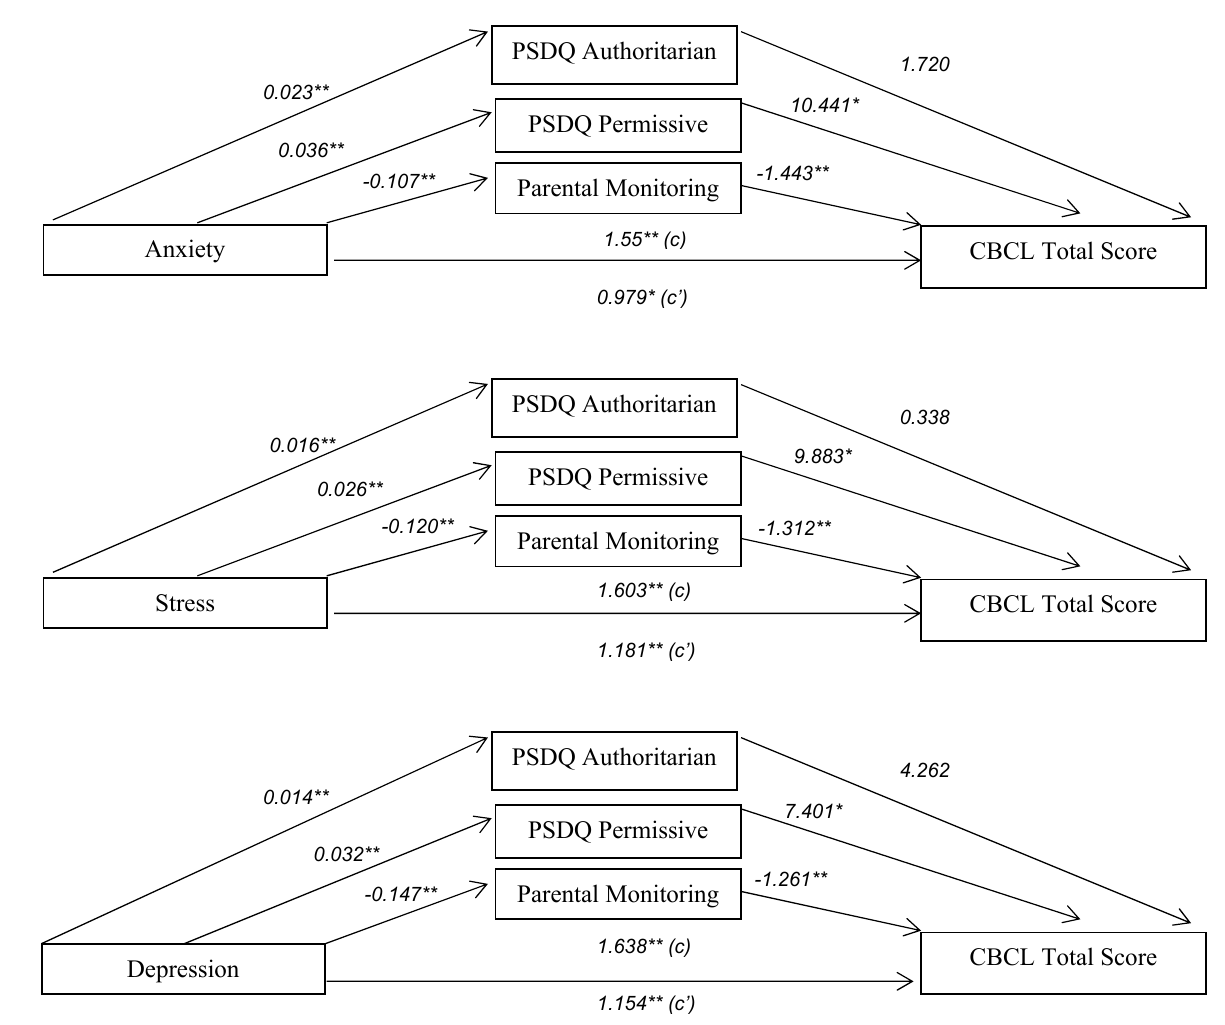
Figure 3. Parental discipline approaches and monitoring skill as mediators of the relationship between parental mental health and adolescent behavioural problems. Note: c = total effect, c’ = direct effect, * p < 0.05, ** p <